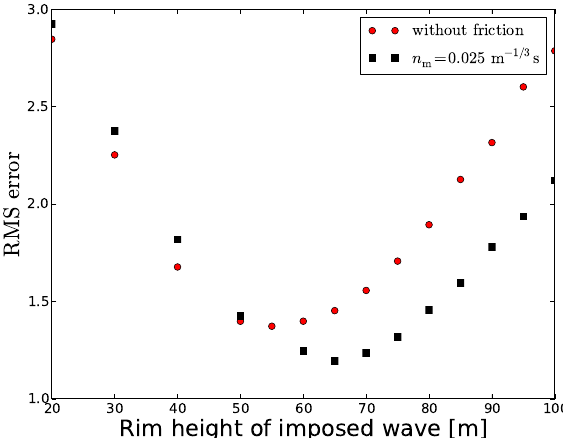
Fig. 4. Root mean square (rms) error of the difference between sim- ulated and measured run-ups at 18 locations around the Karym- skoye lake as a function of imposed amplitude of water rim η 0 . Experiments with no friction (red circles) and Manning coefficient n m = 0 . 025 m − 1 / 3 s (black squares) are